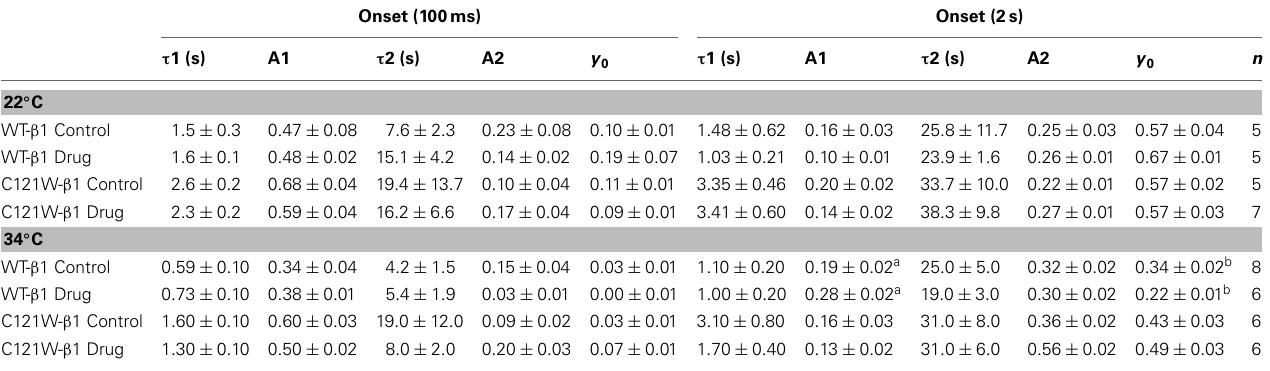
Table 5 | Slow inactivation onset.